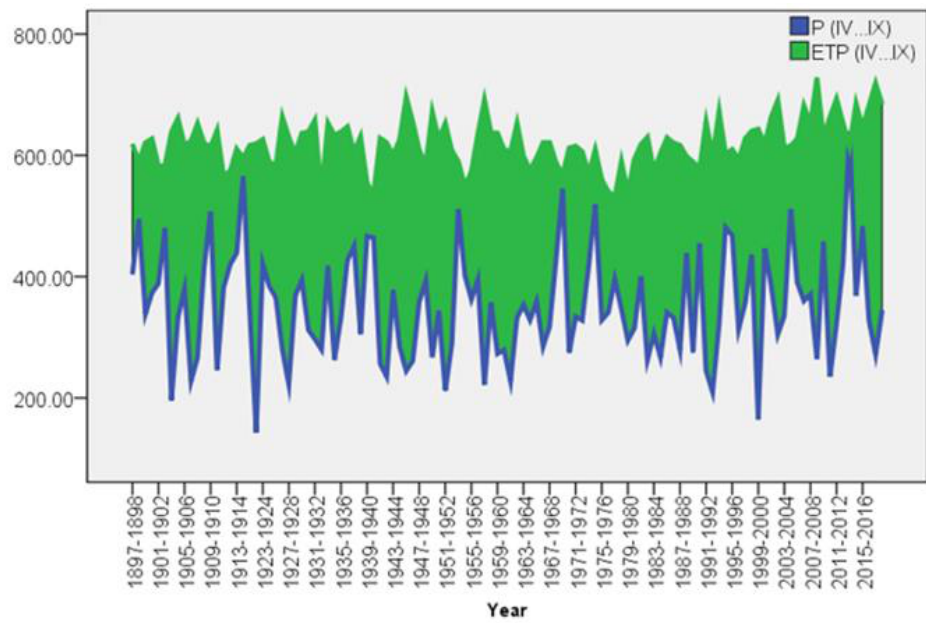
Figure 14. High–Low chart by difference area between cumulative values during the warm period of the year of precipitation (P IV-IX) and evapotranspiration (ETP IV-IX), expressed in mm, recorded annually at the Regional Meteorological Center Banat-Crisana , Romania, 1898-2019.